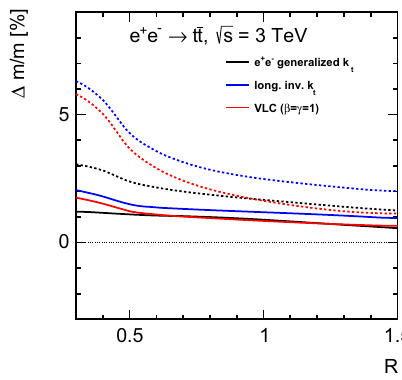
correction, the dashed line to the mean. Results are shown for three algorithms: the generalised e + e − algorithm, the longitudinally invari- √ s = 3 TeV ant k t algorithm and the VLC algorithm with β = 1. The statistical uncertainties of the results are negligible and are not indicated